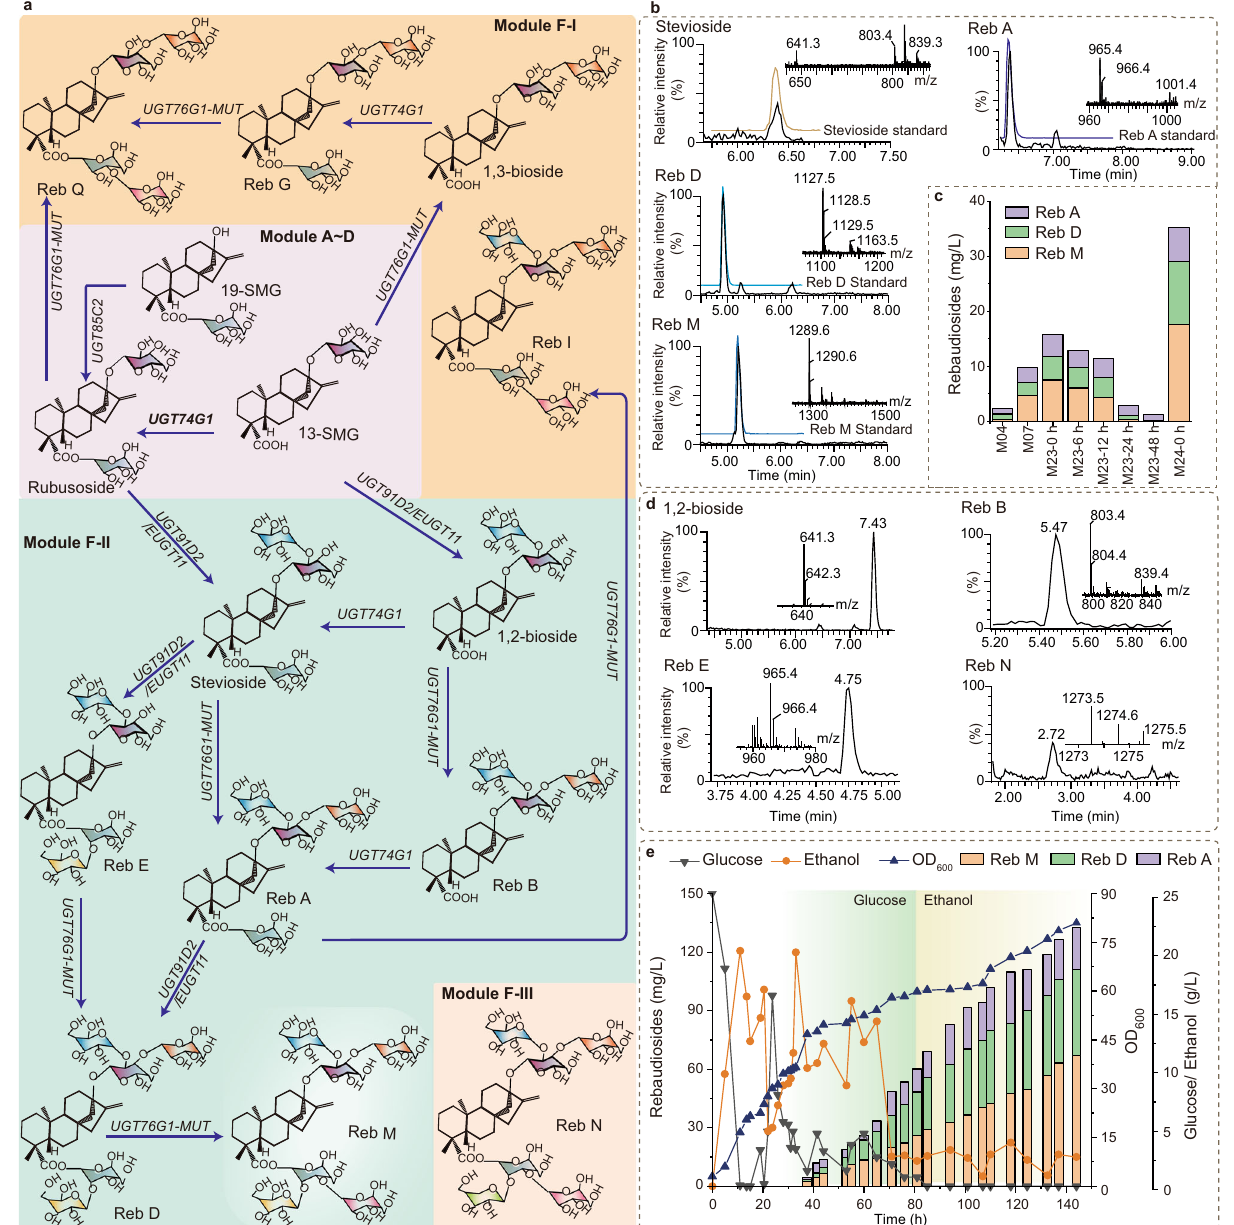
Fig. 5 The de novo biosynthesis platform of rebaudiosides. a Schematic illustration of rebaudiosides biosynthesis based on the rubusoside producing strain. Module F1: the metabolic pathways were reported to exist in S. rebaudiana , but not be detected; Module F2: the metabolic pathways were reported to exist in S. rebaudiana , and the metabolites were hunted in the M23. UGT74G1 UDP-glycosyltransferase 74G1, UGT85C2 UDP-glycosyltransferase 85C2, EUGT11 UDP-glycosyltransferase 91C1, UGT76G1-MUT UDP-glycosyltransferase 76G1. 13-SMG (5 ξ ,8 α ,9 ξ ,10 α ,13 α )-13-( β -D-Glucopyranosyloxy) kaur-16- en-18-säure, 19-SMG 1-O-[(5 ξ ,8 α ,9 ξ ,10 α ,13 α )-13-Hydroxy-18-oxokaur-16-én-18-yl]- β -D-glucopyranose, 1,2-bioside (5 β ,8 α ,9 β ,10 α ,13 α )-13-{ [2-O-( β -D- Glucopyranosyl)- β -D-glucopyran-osyl]oxy} kaur-16-en-18-oic acid, Reb A rebaudioside A, Reb B rebaudioside B, Reb C rebaudioside C, Reb D rebaudioside D, Reb E rebaudioside E, Reb G rebaudioside G, Reb I rebaudioside I, Reb M rebaudioside M, Reb N rebaudioside N, Reb Q rebaudioside Q. b LC-MS analysis results of stevioside, Reb A, Reb D, and Reb M in negative ion mode, analyzed by comparison with the standard product. c The titer changes of rebaudiosides by modifying the EUGT11 (M07), fi ne-turning the UGT76G1 - MUT expression time (M23-0h, M23-6h, M23-12 h, M23-24 h, and M23-48 h) by inducing it expression an 0, 6, 12, 24, and 48 h after fermentation, and strengthening the stress-respond regulator MSN4 (M24). d 1,2-bioside, Reb B, Reb E, and Reb N in negative ion mode, identi fi ed by Progenesis QI v2.4 software. QI software data (Supplementary Data 1) are provided as a Source Data fi le. e Fed-batch fermentation of strain M24 to produce rebaudiosides. The UGT76G1 - MUT expressed before the genes controlled by GAL promoters. All the data represent the mean of n = 3 biologically independent